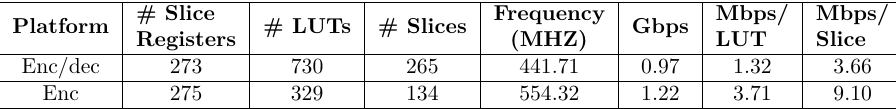
Table 4: TweGIFT-64 Implemented FPGA Results on Virtex